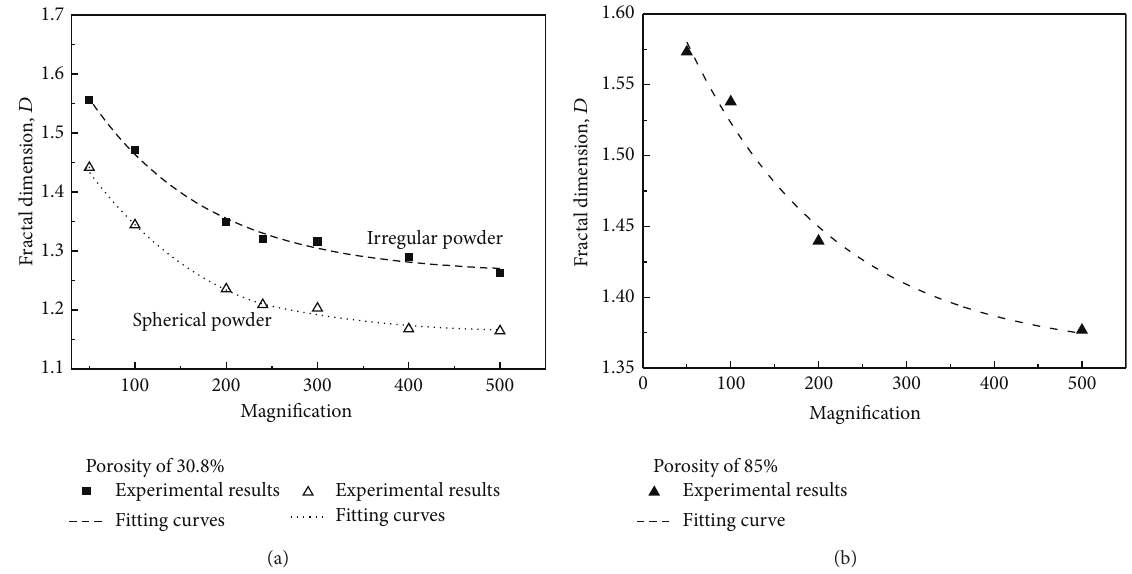
Figure 3: Fractal dimension versus image magnification for (a) porous metal powder materials and (b) porous metal fiber